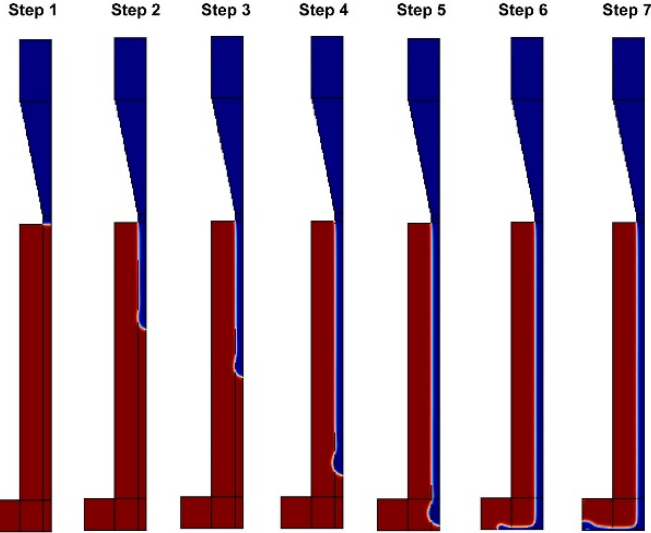
Figure 6. Filament formation in extrusion chitosan 3D printing device with the COMSOL software.